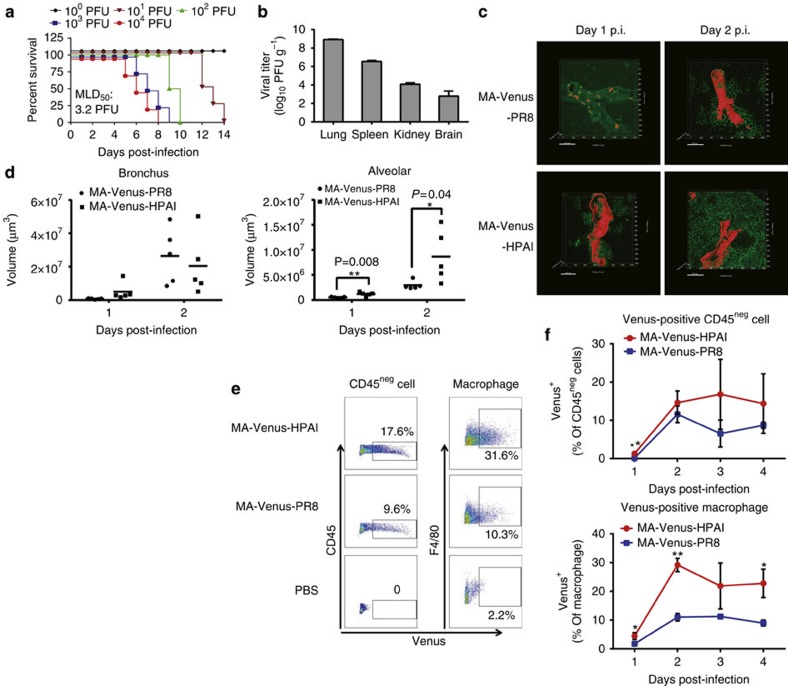
Characterization of MA-Venus-HPAI virus.(a) Four B6 mice per group were intranasally inoculated with MA-Venus-HPAI virus. Mouse body weight and survival were monitored for 14 days. (b) Lungs, spleens, kidneys and brains were harvested from B6 mice at day 3 p.i. with 105 PFU of MA-Venus-HPAI virus. Virus titres of tissue homogenates were determined by use of plaque assays in MDCK cells. Each data point represents the mean±s.d. (n=3). (c,d) Lung tissues were harvested from B6 mice at day 1 and 2 p.i. with 105 PFU of MA-Venus-HPAI and PR8. Images of transparent lung tissues with Venus-positive cells in the bronchus (red) and alveolar area (green) were obtained by using a two-photon microscope. Each data point represents the mean±s.d. (n=3). Statistical significance was calculated by using the Student’s t-test. (d) The distribution of Venus-positive cells was evaluated via volume analysis of the Venus-positive bronchus and alveolar area by using 3D images of the transparent lung tissues. (e,f) Cells were collected from lungs of B6 mice at days 1, 2, 3 and 4 p.i. with 105 PFU of MA-Venus-PR8 or MA-Venus-HPAI virus, and stained for CD45, CD11b and F4/80. Venus expression in CD45-negative cells, and the Venus versus F4/80 staining profile gated on CD45-positive cells were analysed by flow cytometry. (e) A representative dot plot from day 2 p.i. is shown with the percentage of Venus-positive cells.